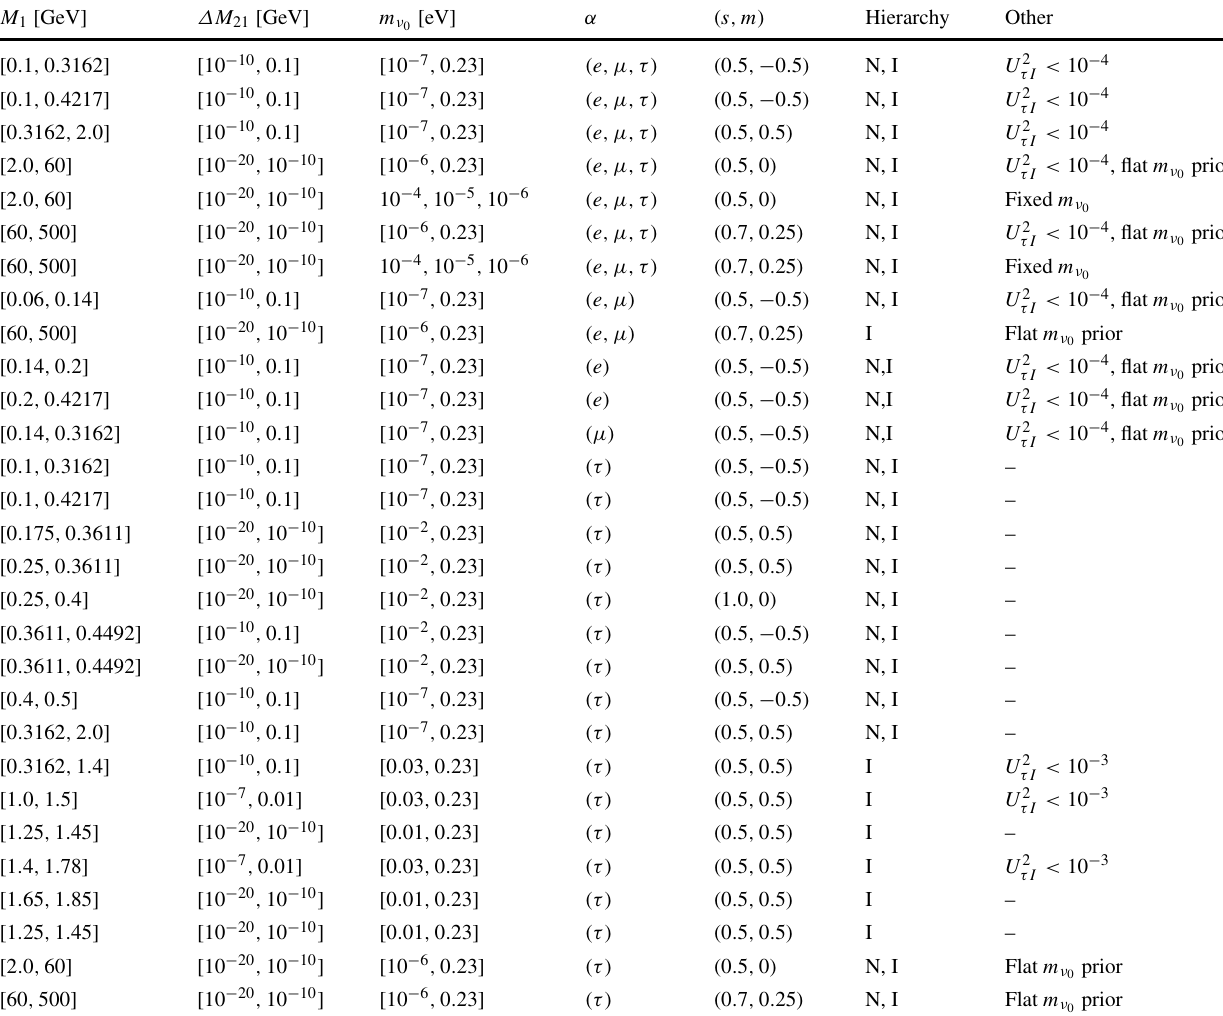
Table 6 Set of targeted scans performed for normal (N) and inverted (I) hierarchy in addition to the full parameter scans. Parameters not shown in this table are taken as in Table